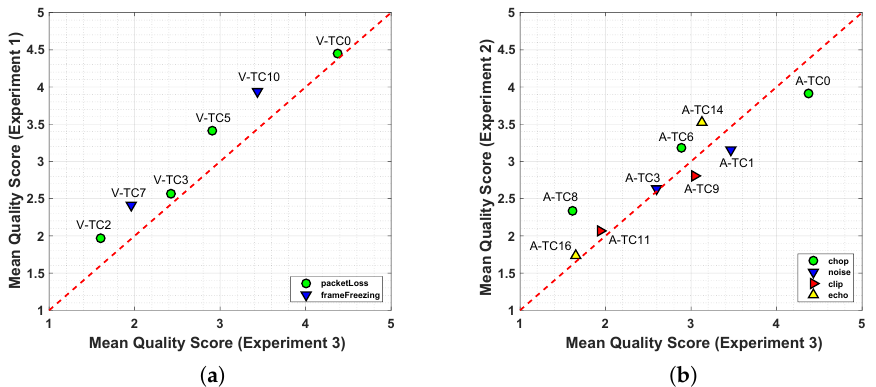
Figure 12. Comparison of MQS values values for: ( a ) Experiment 1 versus Experiment 3 and ( b ) Experiment 2 versus Experiment